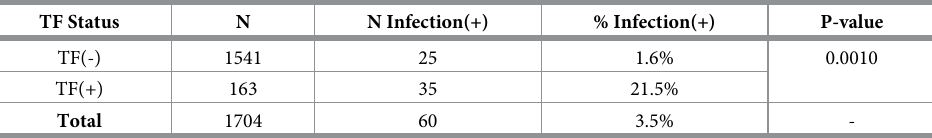
Table 3. Relationship of TF in children ages 1–9 years with a positive test of infection (N = 1704).